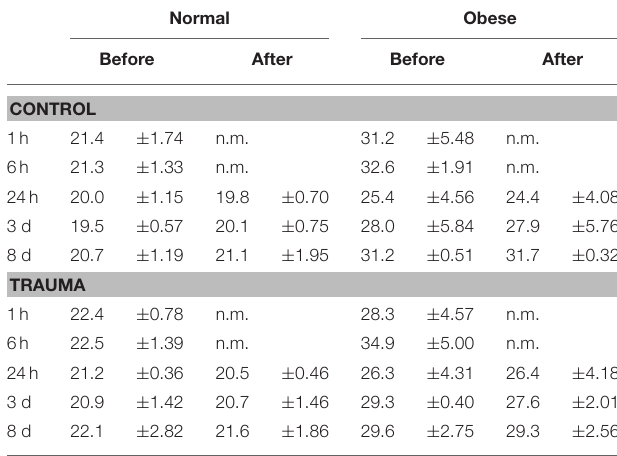
TABLE 2 | Effect of blunt muscle injury on the weight of normal weight and obese